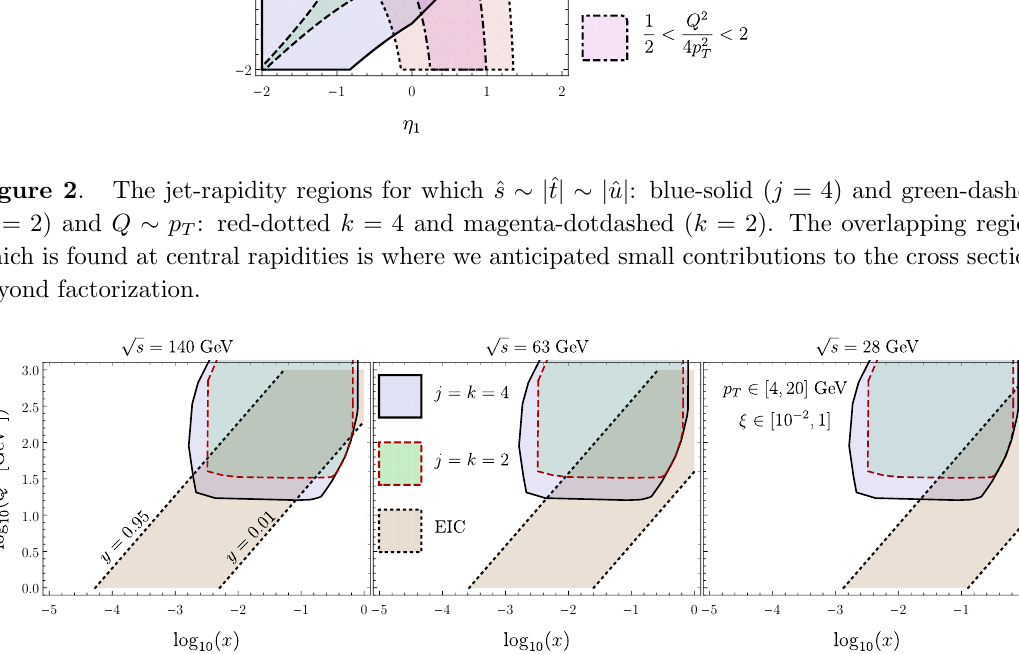
Figure 3 . The ( x; Q 2 ) coverage of EIC (brown/dashed) compared to the di-jet events with j = k = 4 factorization regime (blue-solid) and with j = k = 2 (green-dashed). The factorization regime has been constructed assuming p T overlapping region in (cid:12)gure